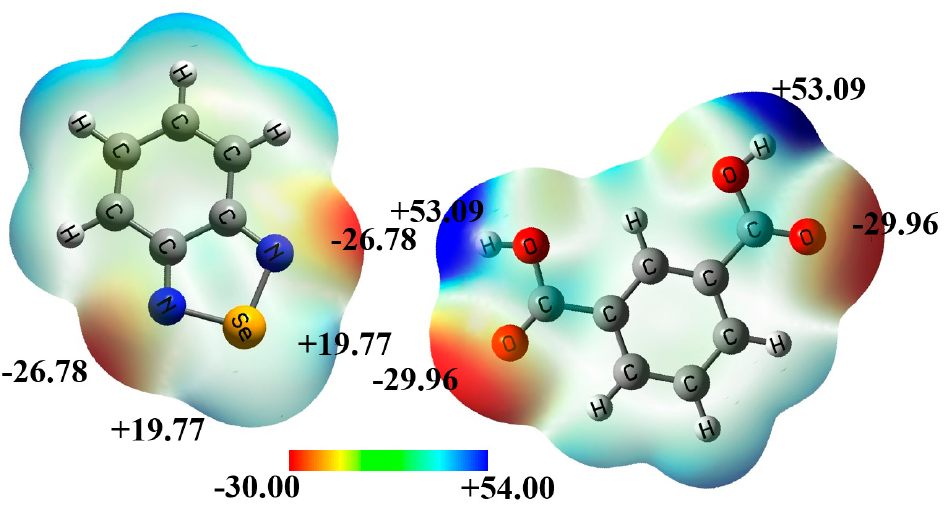
Figure 2. The molecular electrostatic potential maps of 2,1,3-benzoselenadiazole and isophthalic acid. The numbers (in kcal/mol) are the local surface maxima or minima of the electrostatic poten- tials.